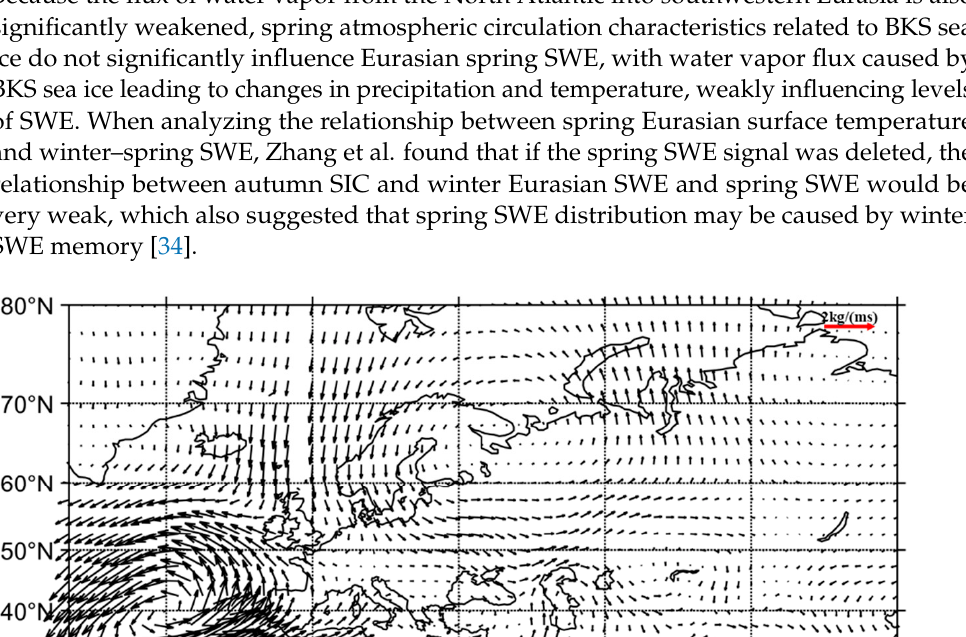
Table 3. Comparison of forecasted values and actual results of Eurasian SWE in autumn and winter from 2000 to 2018.